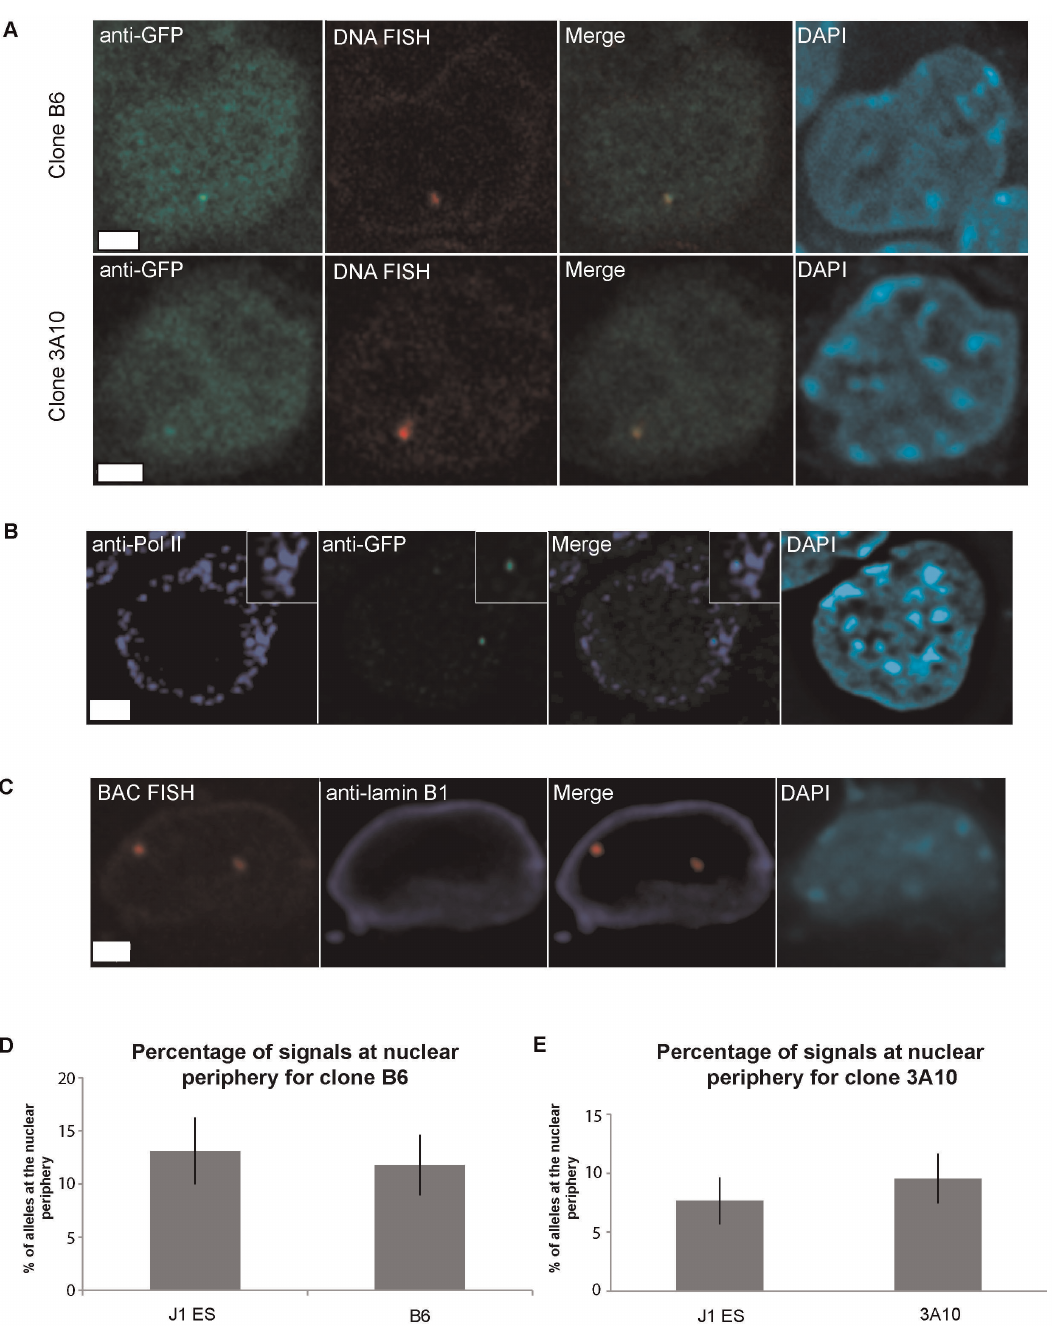
Figure 3. Nuclear positioning of transcriptional foci. A. ImmunoFISH of Clone B6 (top) and Clone 3A10 (bottom) with their respective BAC probes (red) against the integration site, and immunofluorescence staining with EGFP antibodies (green) and DAPI (cyan). A single focal plane with the focal dot is shown. B. ImmunoFISH of Clone B6 cells showing an EGFP focal dot (green) located at RNA Pol II factories (violet) and DAPI (cyan). A single focal plane with the focal dot is shown. Scale bar=2.5 m M. C. Representative image of Dlgap4 loci (red) in Clone B6 with respect to the nuclear periphery (violet). The nucleus is counterstained by DAPI (cyan). Scale bar=2.5 m M. Image shown is the maximal projection of multiple stacks. D. Quantification of the percentage of BAC FISH signals marking the Clone B6 integration site found at the nuclear periphery compared to J1 cells (n=3, 104–140 FISH signals were counted for each n). E. Quantification of the percentage of BAC FISH signals marking the Clone 3A10 integration site found at the nuclear periphery compared to J1 cells (n=4, 106–134 FISH signals were counted for each